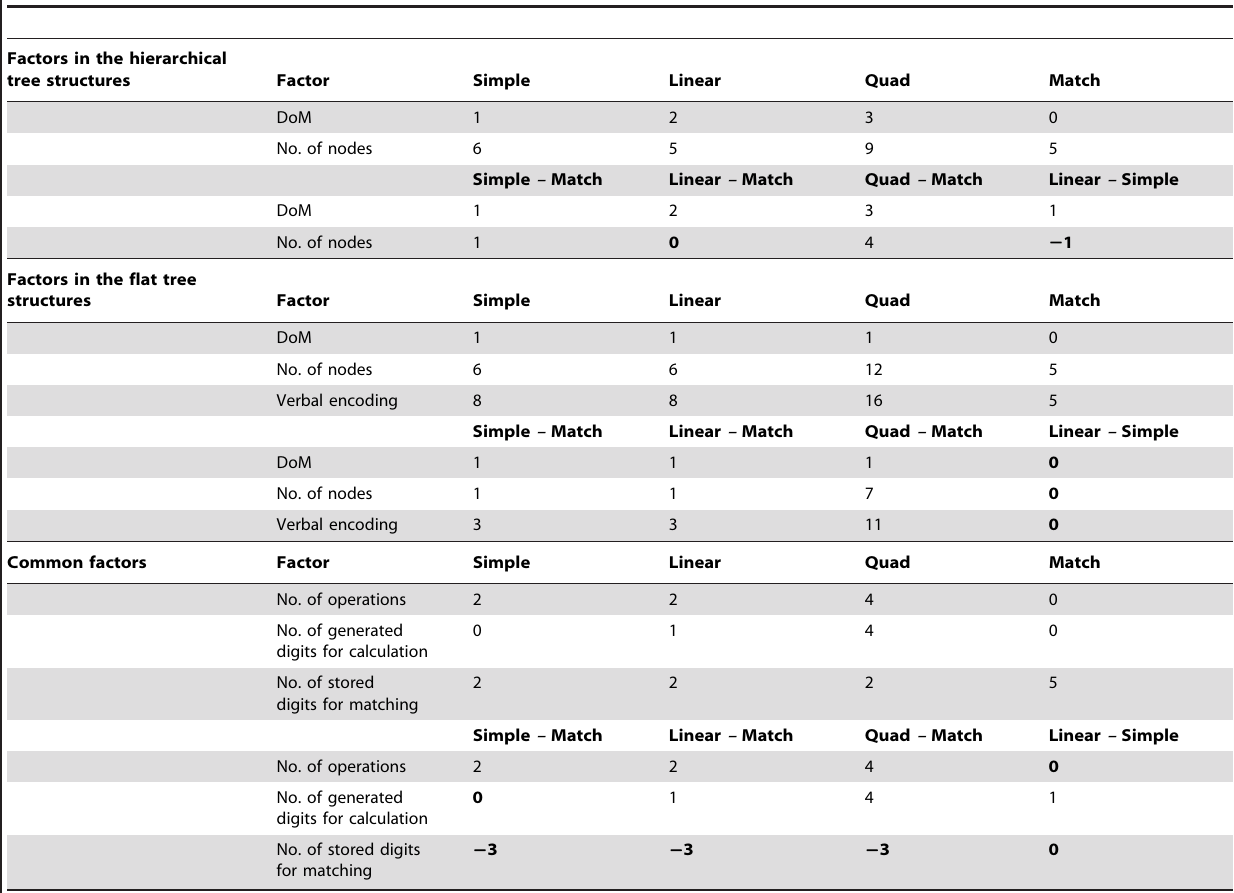
Table 1. Estimates of various factors to account for